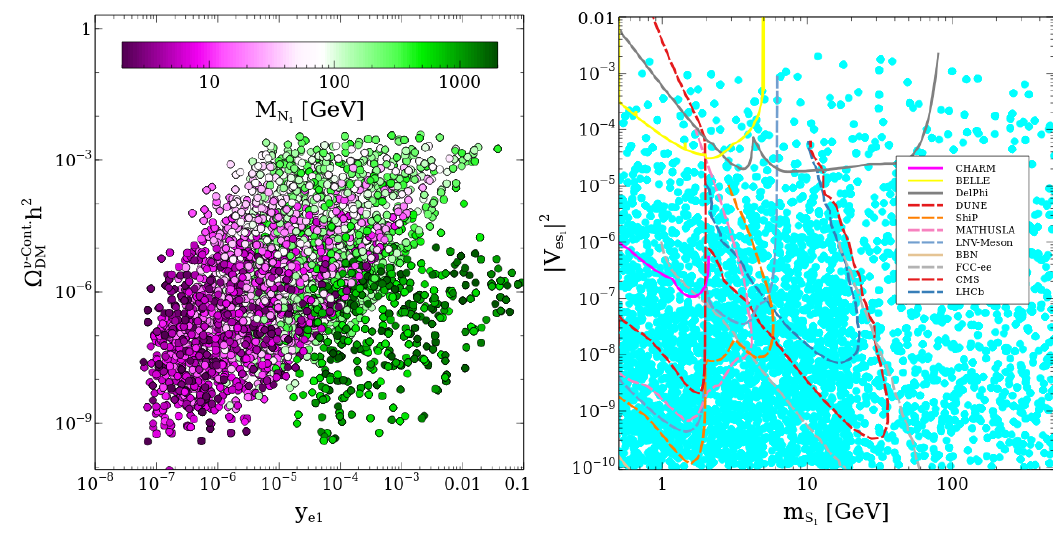
– | V 2 (right) planes h 2 (left) and m S eS 1 | DM 1